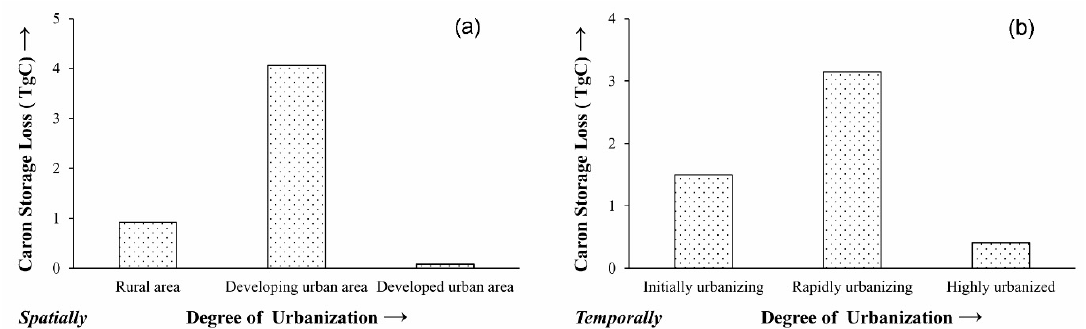
Figure 7. The regularities of spatiotemporal changes in carbon storage in response to urbanization. Vertical axis: the amount of carbon storage loss. Horizontal axis: the degree of urbanization in ( a ) space and ( b ) time.